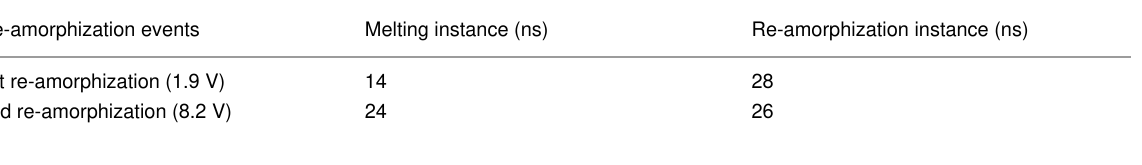
Table 3: Melting and re-amorphization instances (i.e., the switching time values used for two re-amorphization events in simulations). Re-amorphization